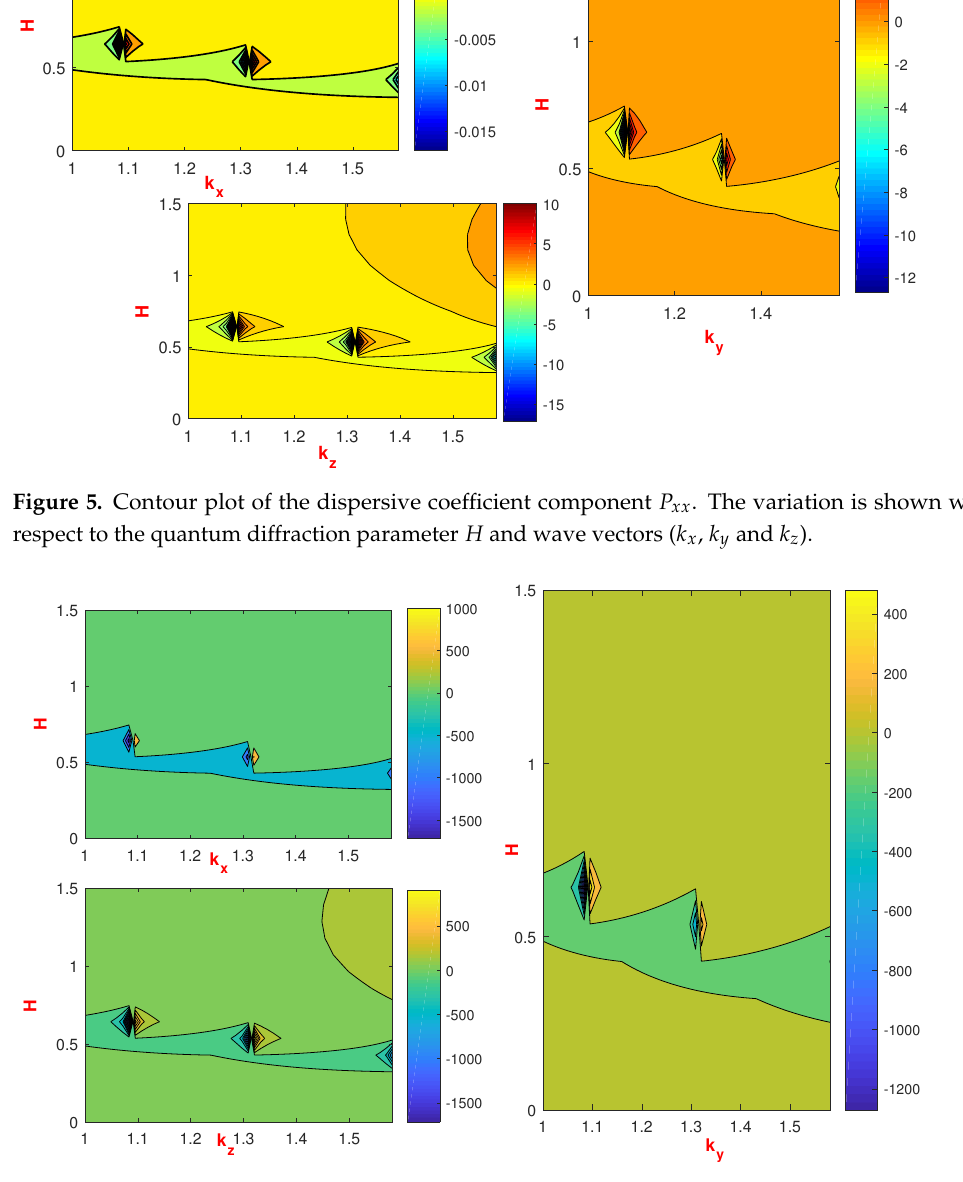
Figure 6. Contour plot of the dispersive coefficient component P yy . The variation is shown with respect to the quantum diffraction parameter H and wave vectors ( k x , k y and k z